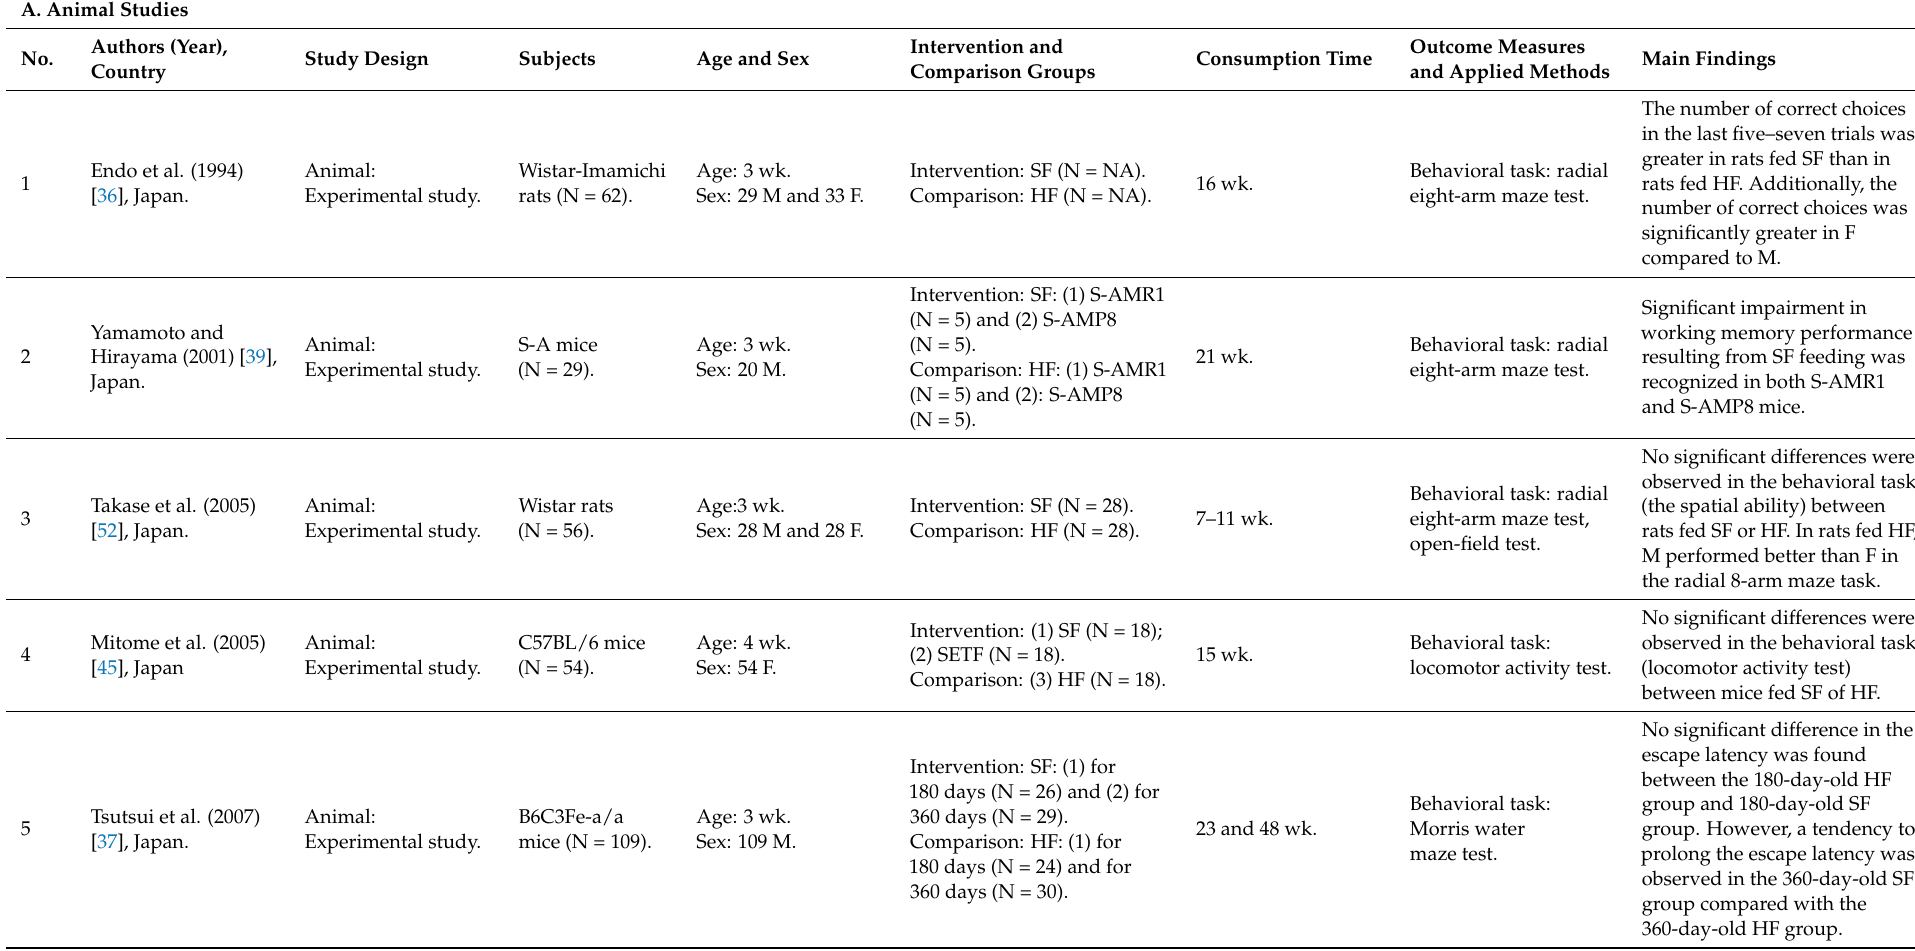
Table 2. Overview of the included